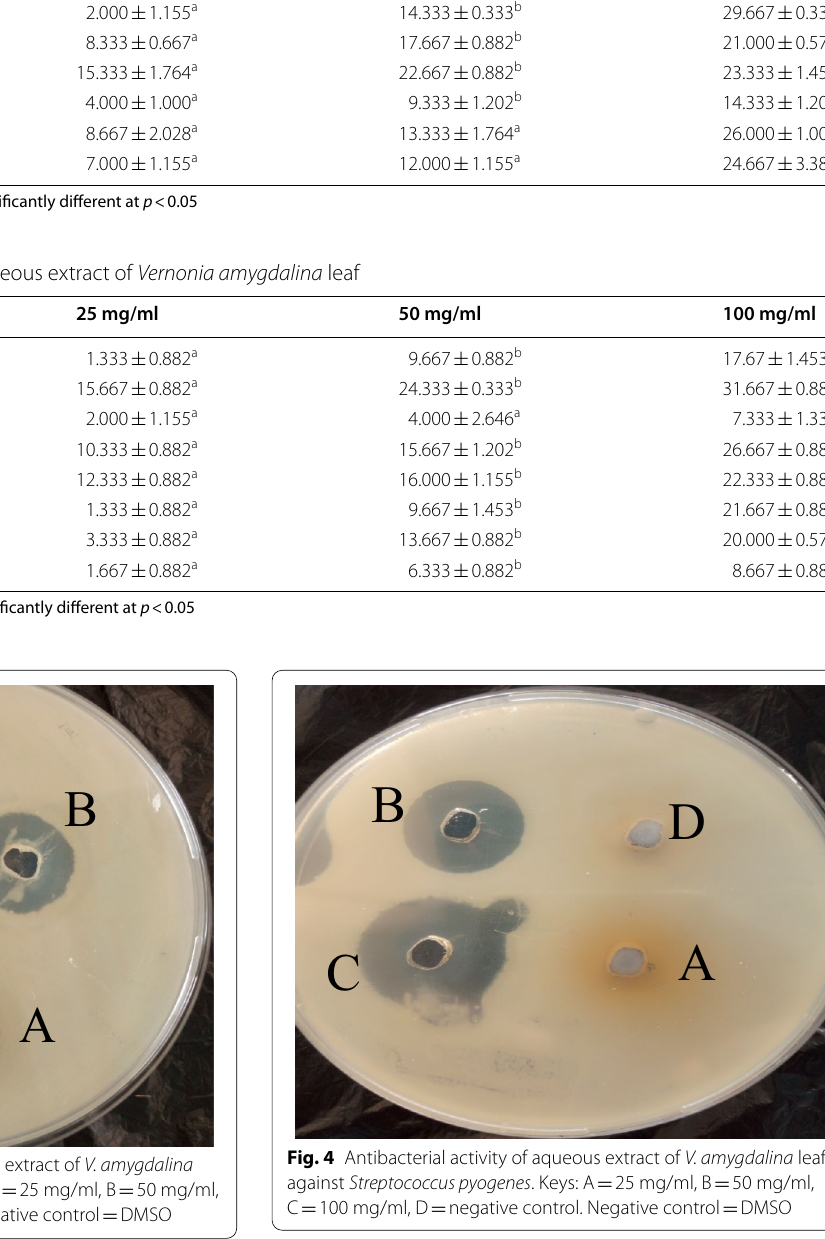
25 mg/ml, B 50 mg/ml, = = DMSO =